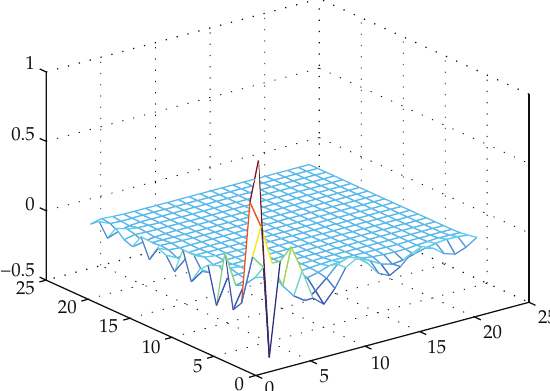
Figure 2: State variable x 2 of system (cid:2) 2.1 (cid:3)